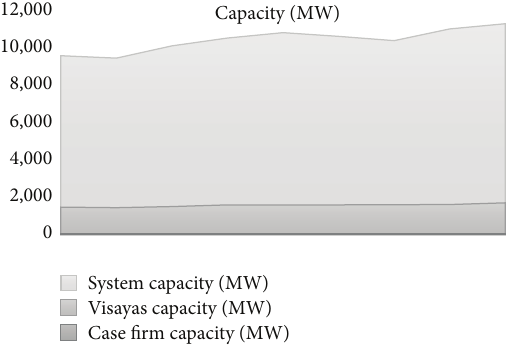
Figure 1: Capacity comparison